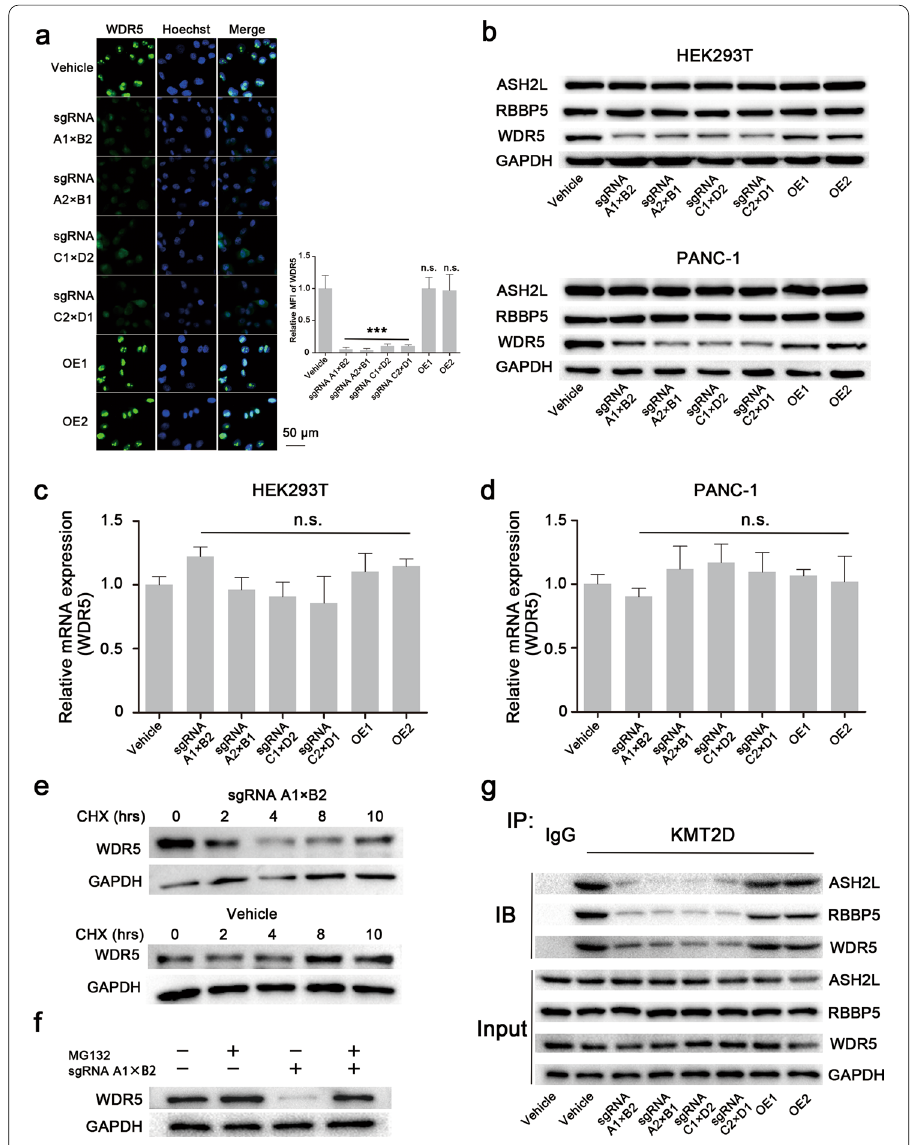
Fig. 5 KMT2D LCDs modulate the stability of WDR5 protein and influence the formation of the KMT2D-enzyme complex. a Representative images of cell immunofluorescence detecting the WDR5 expression in modified-PANC-1 cells. The WDR5 level had markedly reduced in the LCD-depleted cells, but normal expression was recovered in OE1 and OE2 cells. b Western blotting analyses of the KMT2D-enzyme complex, including WDR5, ASH2L, and RBBP5, in HEK293T and PANC-1 cells. Knockout of KMT2D LCDs significantly attenuated WDR5 expression, but the expressions of ASH2L and RBBP5 were not affected. In OE1 and OE2 cells, WDR5 expression is restored. ASH2L, 69 KDa; RBBP5, 59 KDa; WDR5, 36 KDa; GAPDH, 37 KDa. c , d RT-PCR analyses of WDR5 gene expression. After LCD deletion in HEK293T and PANC-1 cells, the gene expression of WDR5 was similar to that in OE1 cells, OE2 cells, and control group (vehicle; error bars denote standard deviation). e , f Western blotting analyses of WDR5 protein expression with CHX or MG132 treatment. The WDR5 protein level in KMT2D LCD knockout cells gradually decreased with the time after CHX treatment compared with the wild-type cells, indicating that the stability of WDR5 protein is closely related KMT2D LCDs. g Co-immunoprecipitation analyses of the interactions between KMT2D and other components. The interactions between KMT2D and WDR5 were significantly reduced in KMT2D LCD-depleted PANC-1 cells. Similar results were found for the interactions of KMT2D with ASH2L and RBBP5. In OE1 and OE2 cells, these interactions were restored. All values are represented as means SD. Data are representative of three ± independent